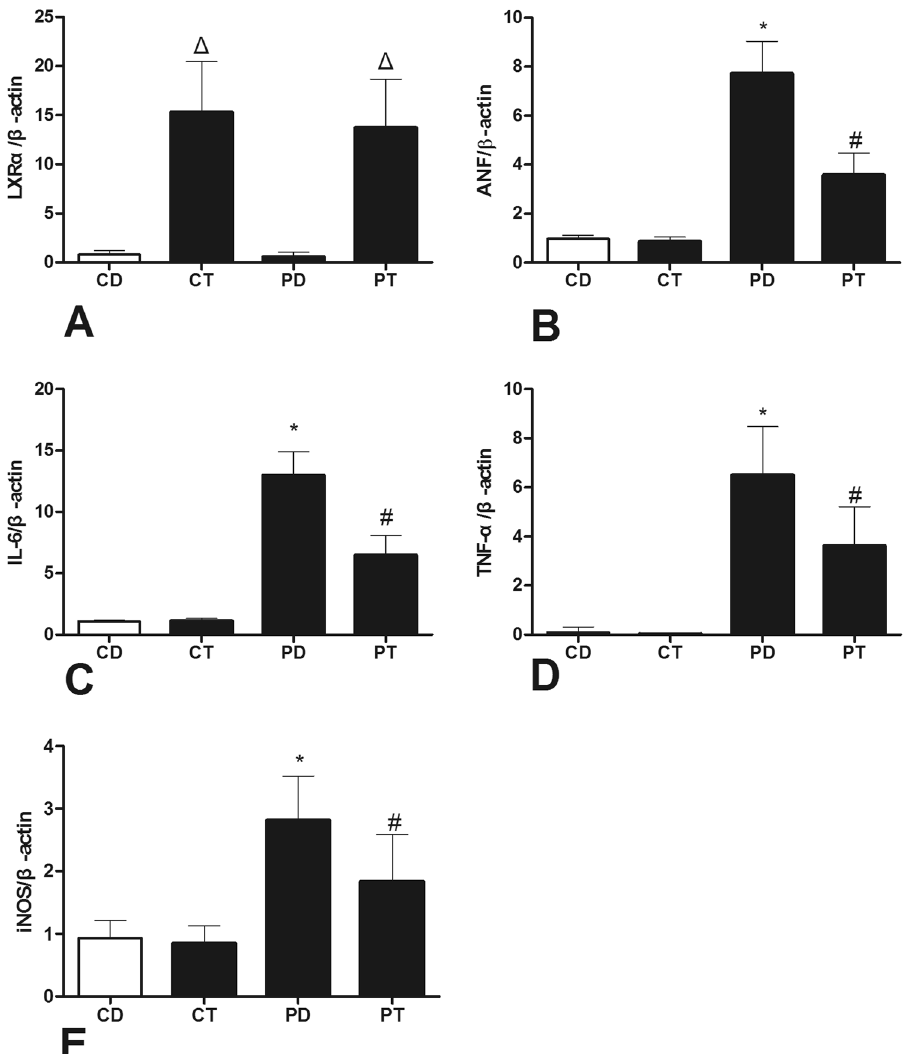
Figure 4. Effects of LXR antagonist administration on RNA activation. Real-time examination revealed mRNA changes of LXR α ( A ), ANF ( B ), TNF- α ( C ), IL-6 ( D ), and iNOS ( E ) expression in rats. RNA was obtained from rat right ventricular myocardiocytes. (CD: rats treated with NS + DMSO, CT: rats treated with NS + T0901317, PD: rats treated with MCT + DMSO, PT, rats treated with MCT + T0901317). (n = 6, Δ : vs CD/PD P < 0.05, * vs CD P < 0.05, # vs PD P <